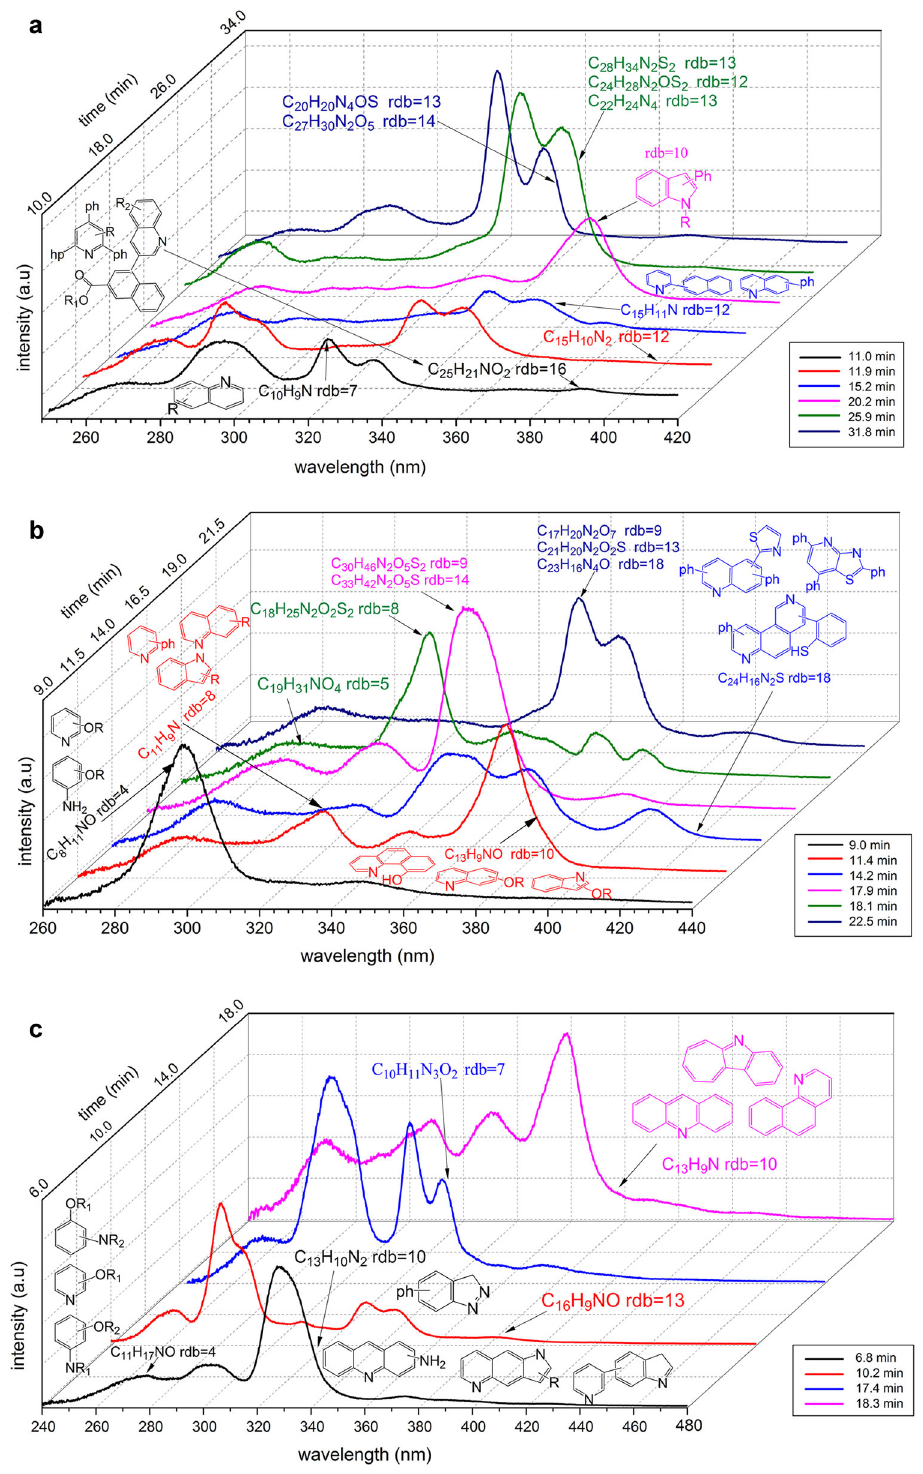
Fig. 4 Fluorescence spectra of fraction a ( a ), fraction b ( b ) and fraction c ( c ) (Time in labels referred to the moment when the FL spectrometer began to scan at 240 nm at a rate of 240 nm/min. Furthermore, it took the compound 0.75 min from FL detector to MS detector. Besides, the ph referred to